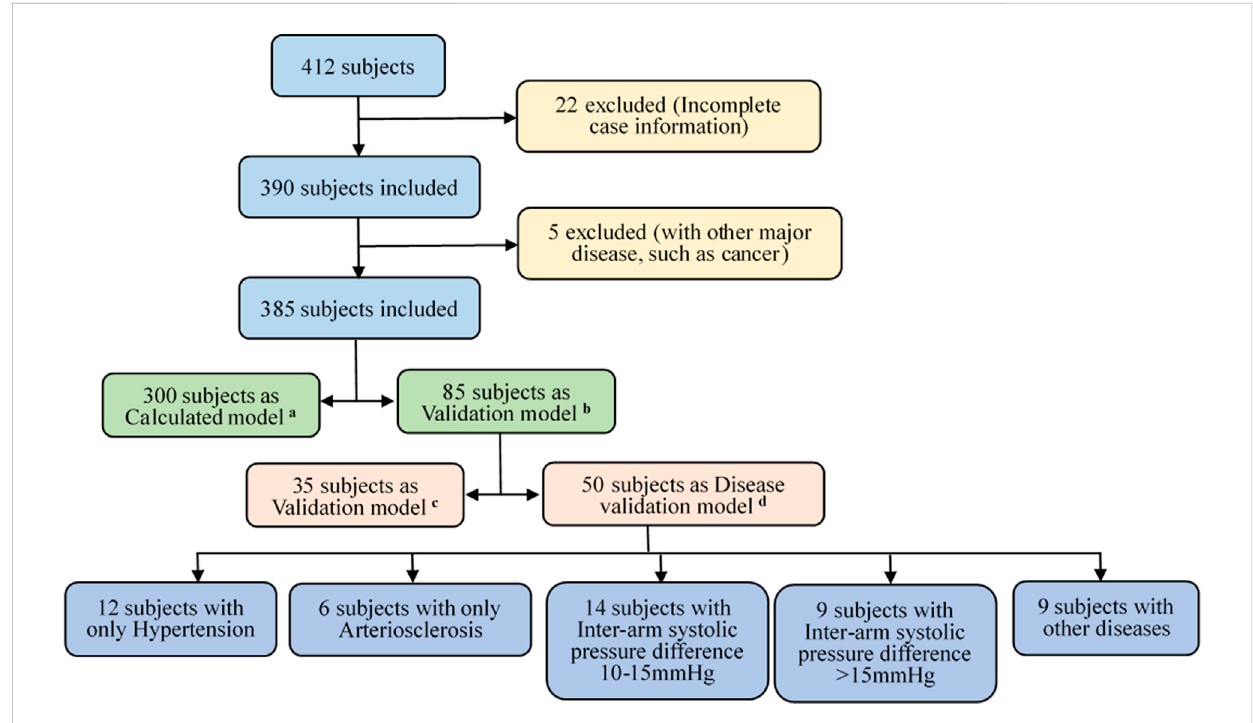
FIGURE 2 Subjects ’ datascreeningprocess.Screeningcriteria (A – D) : (A) calculatedmodelgroupof300subjects, (B) validationmodelgroupof85subjects; (C) verifying the accuracy of the model using 35 randomly-selected subjects, and (D) another 50 randomly-selected subjects and under different disease conditions.